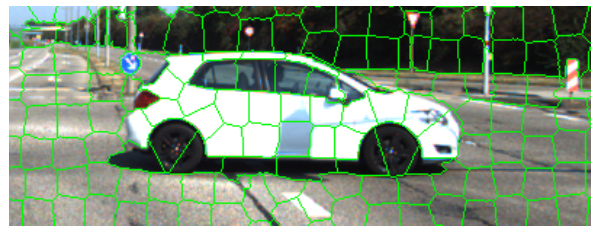
Figure 4. Superpixels. Typical oversegmentation of a